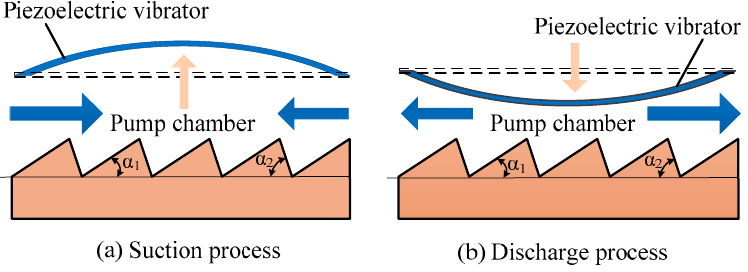
Figure 5. Working principle of a valveless piezoelectric pump with built-in structures.